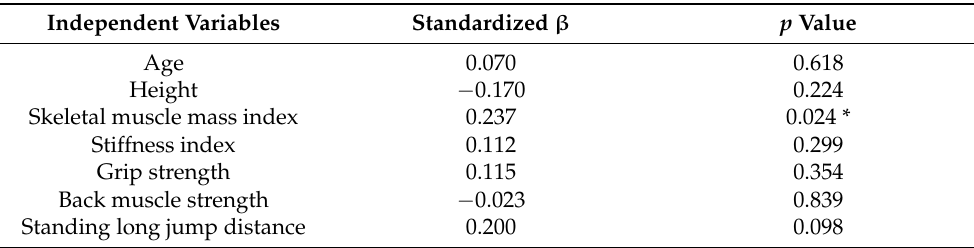
Table 3. Multiple regression analysis with MVPA performance time as the dependent variable among the all participants ( n =